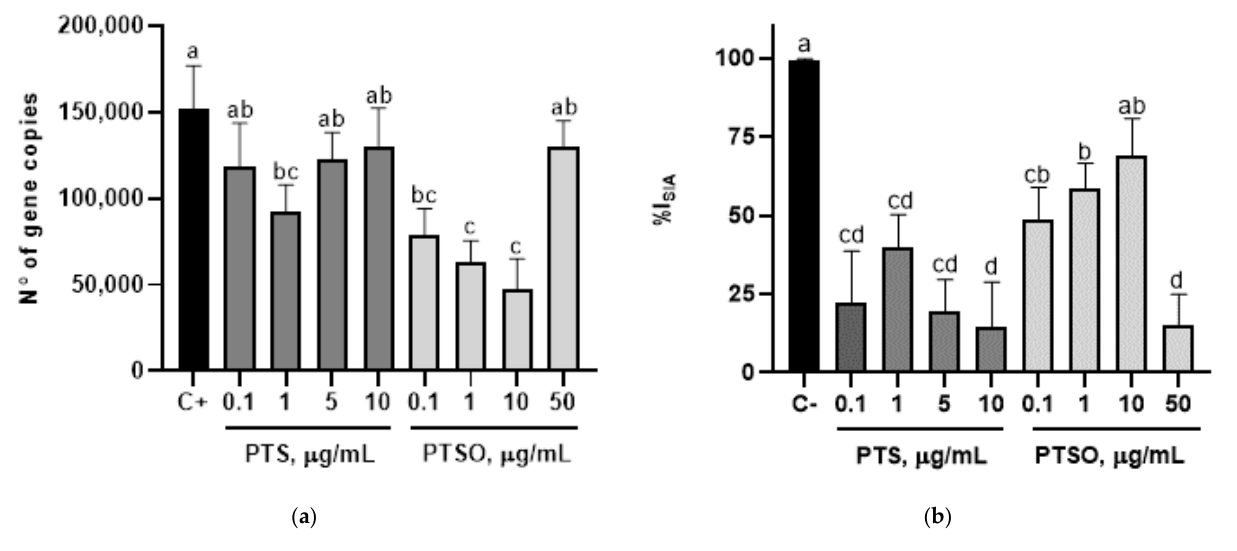
Figure 3. Viability percentage of MDBK cells infected with E. acervulina sporozoites that were pre- viously incubated at different concentrations of PTS or PTSO. Different letters between columns indicate significant differences at p < 0.05.